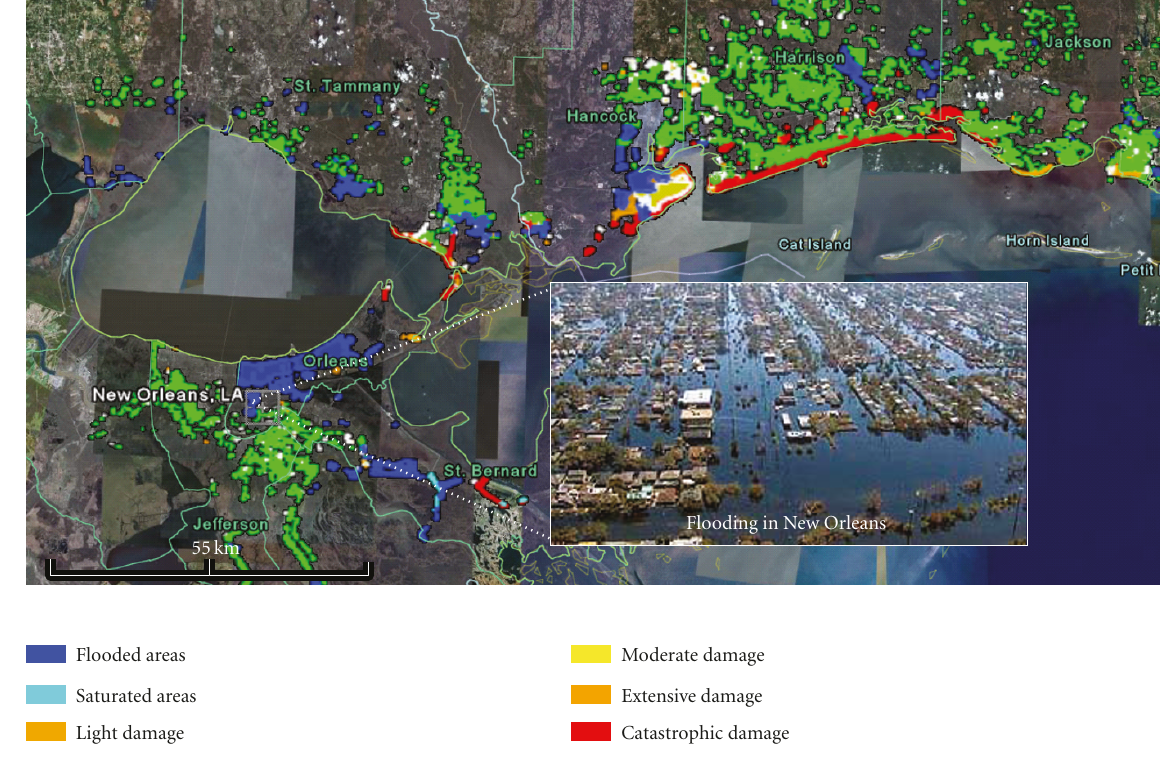
Figure 1: Hurricane Katrina damage area [3].